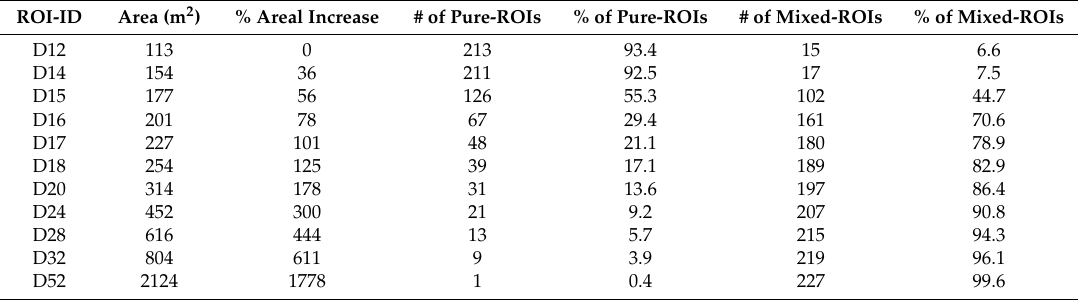
Figure 3. ( A – C ) Spatial delineation of ROIs with sample wetland classes and aquatic habitats selected from the Selenga River Delta landscape (Top panels are true-color images for A : predominantly terrestrial habitats; B : predominantly lotic habitats, and C : predominantly lentic habitats; see bottom-panel class descriptions in Table 1). The ROI diameters range from 12 to 52 m (see Table 2). Table 2. Description of training and validation datasets by region of interest (ROI) size (D is diameter followed by the associated value in m, e.g., D12 is a ROI with a 12-m diameter). There are 228 ROIs.